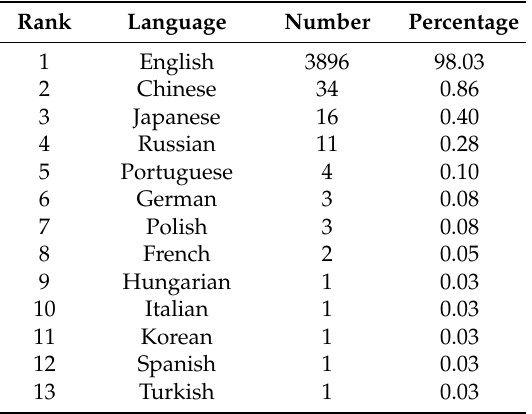
Table 2. Languages of P. ginseng